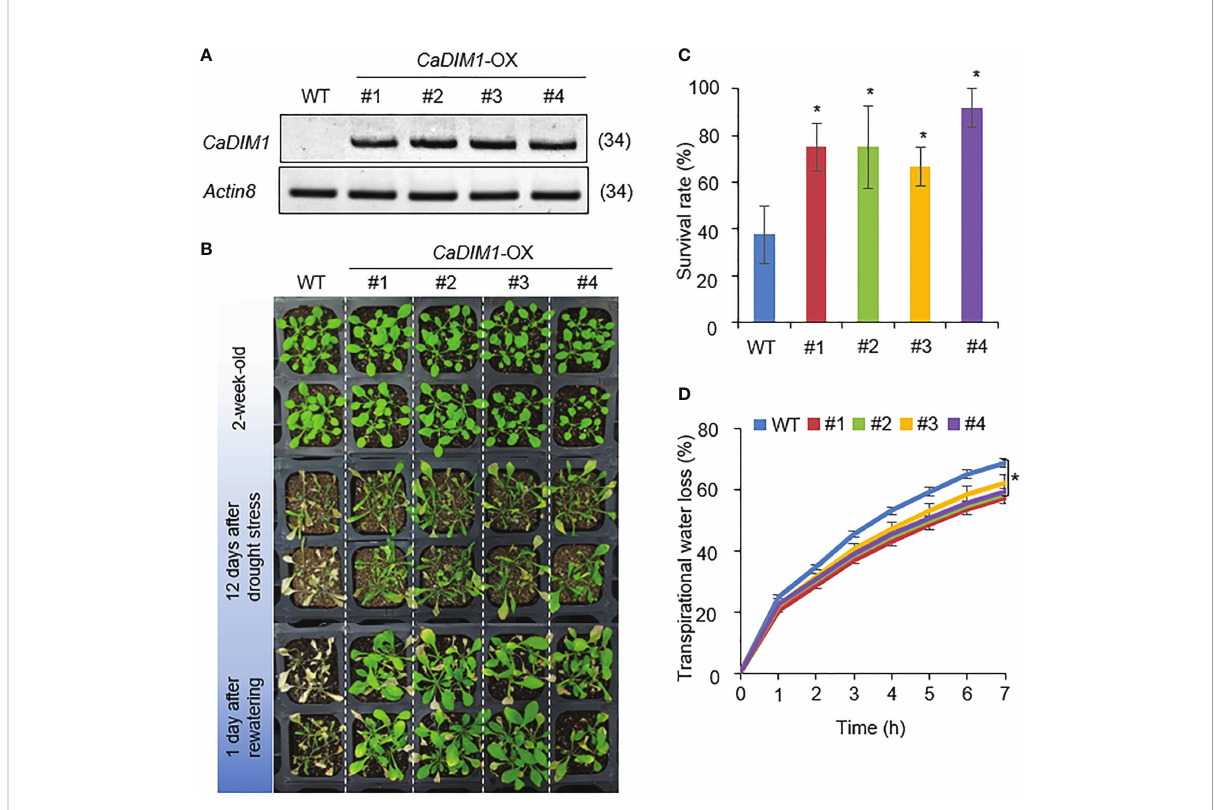
FIGURE 4 Enhanced tolerance of CaDIM1 -overexpressing (OX) transgenic Arabidopsis plants to drought stress. (A) RT-PCR analysis of wild-type (WT) and CaDIM1 -overexpressing (OX) transgenic Arabidopsis plants. The Arabidopsis Actin8 gene was used as an internal control. (B) Drought-tolerant phenotype of CaDIM1 -OX transgenic plants. Two-week-old wild-type (WT) and transgenic plants were subjected to drought stress by withholding watering for 12 days and subsequently re-watering for 1 day. The survival rate of each line was measured after re-watering. Data represent the mean ± standard error of three independent experiments; in each of these experiments, 20 plants were evaluated. (C) Survival rates of wild-type and transgenic plants after 1 day of re-watering. Data represent the mean ± standard error of three independent experiments; in each of these experiments, 20 plants were evaluated. (D) Transpirational water loss from the leaves of wild-type and transgenic plants at different time points after leaf detachment. Asterisks indicate signi fi cant differences between wild-type and CaDIM1- OX plants (Student ’ s t -test; * P <